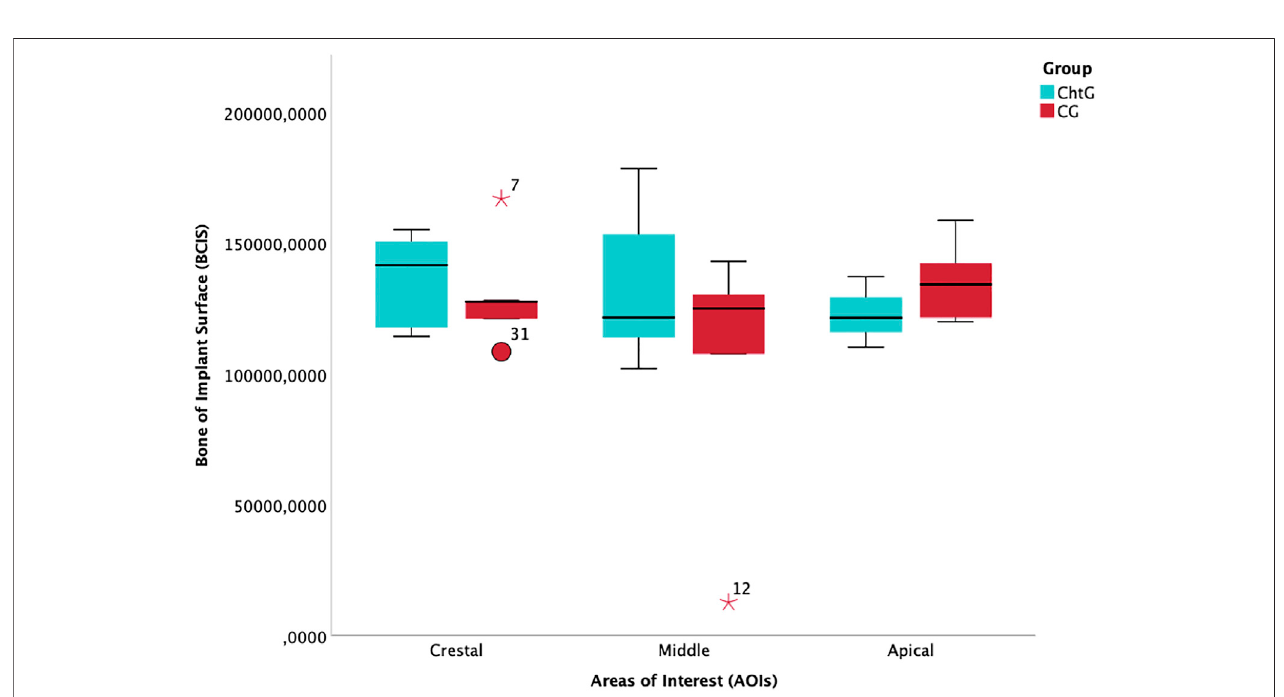
FIGURE 7 | Boxplot of bone in contact with the implant surface (BCIS) values at crestal, mid and apical levels.